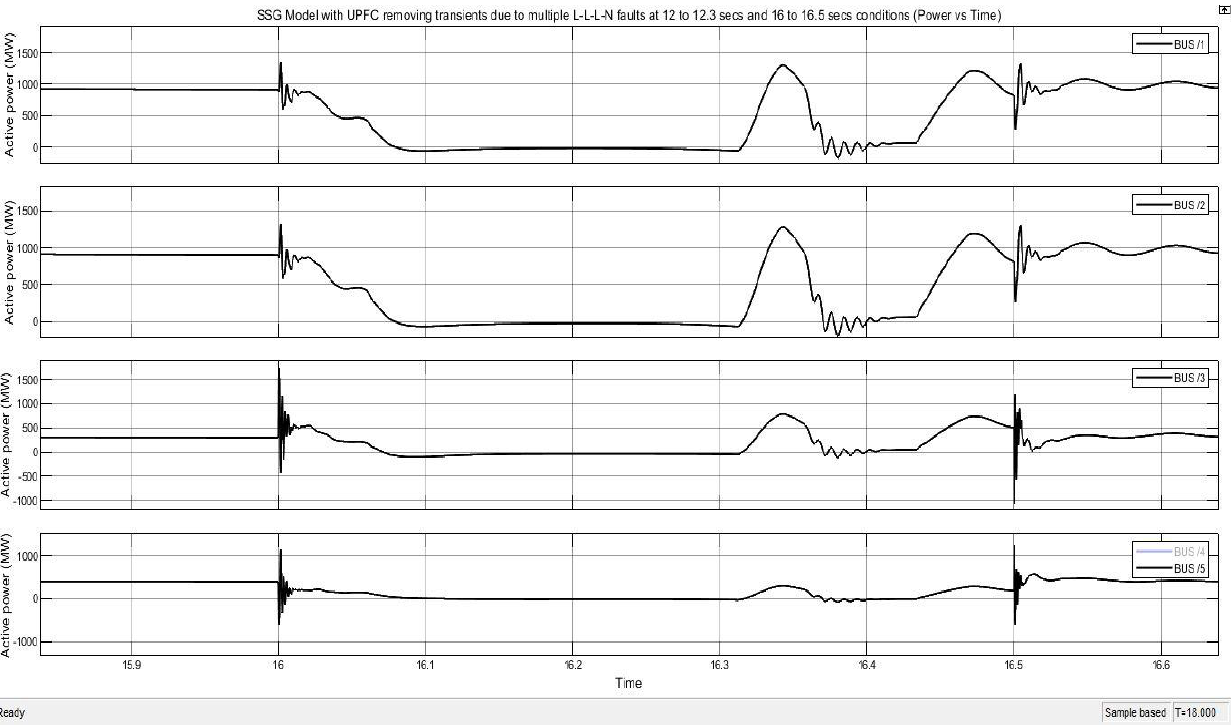
Figure 35. Transient stability being provided by UPFC after multiple L-L-L faults are introduced at 12 to 12.3 s (Bus 1 to Bus 5).